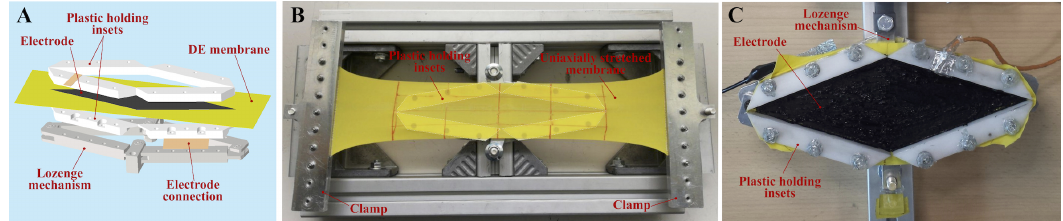
Figure 3. ( A ) Exploded view of the experimental LS-DEA prototype. ( B ) DE membrane pre-stretching and installation on the lozenge mechanism. ( C ) Picture of the final LS-DEA assembly.